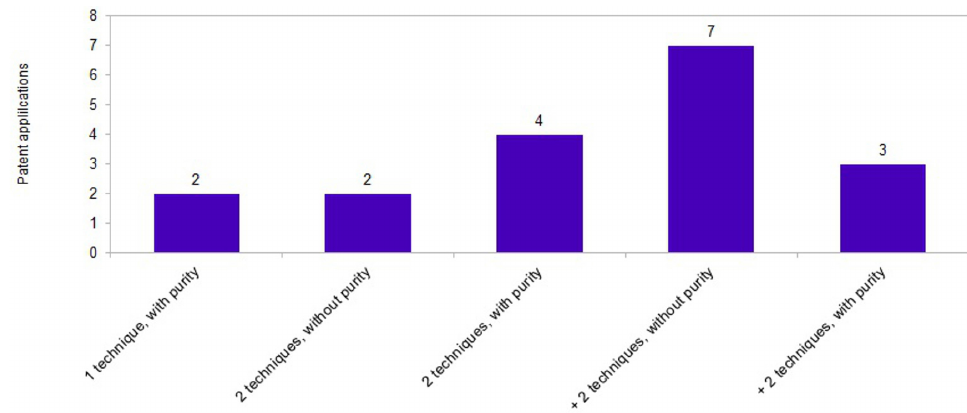
FIGURE 4 – Number of techniques present in patent applications for clopidogrel crystalline forms.